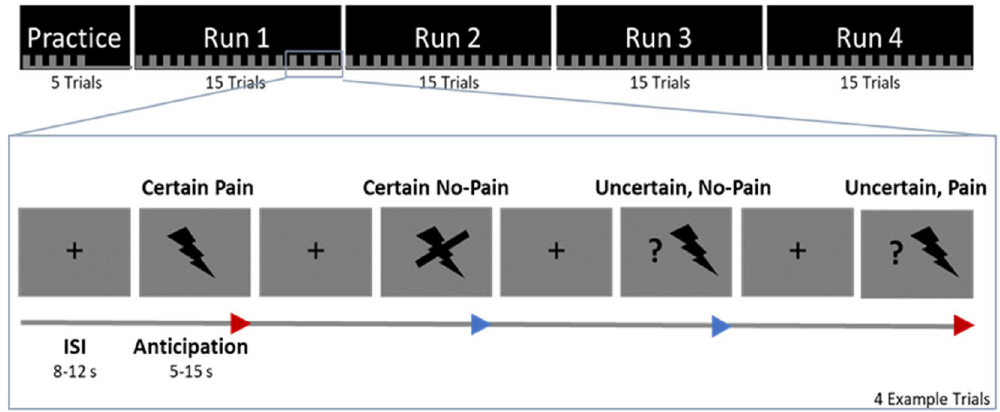
Figure 1. Overview of the experimental paradigm. After calibration and a short practice, participants did four blocks of the experiment with 15 trials each. Overview of the experimental paradigm. Painful and non-painful stimuli were administered in randomized order. Cues indicating the type of trial were presented 5–15 s prior the stimulus and persisted during the actual transcutaneous electrical stimulation. A thunderbolt cued for a painful stimulation, a crossed-out thunderbolt for a non-painful trial. The thunderbolt with question mark indicated an uncertain trial (50% painful/non-painful) and therefore provided no information about the upcoming